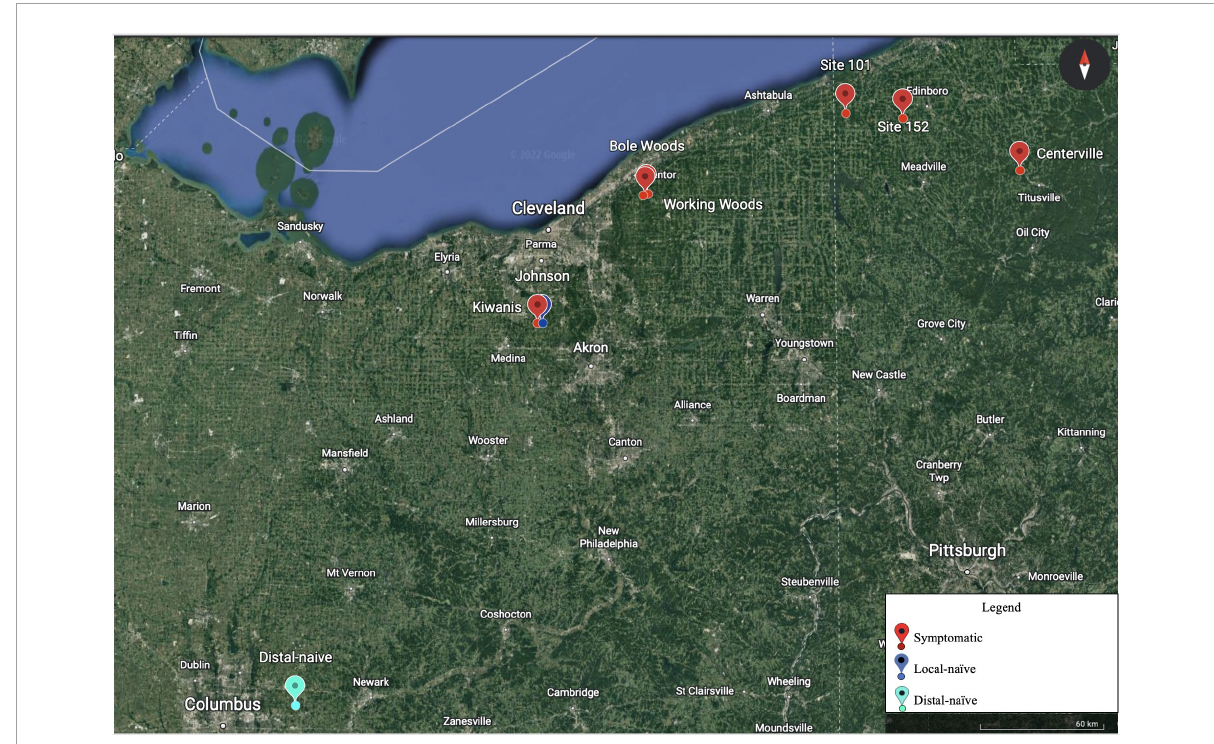
FIGURE1 Eight sampling plots were chosen for the near-infrared (NIR) spectral collection over the various time points in Ohio and Pennsylvania. The symptom type of each plot is indicated by the color in the legend (Google Earth 9. 156. 0. 0,